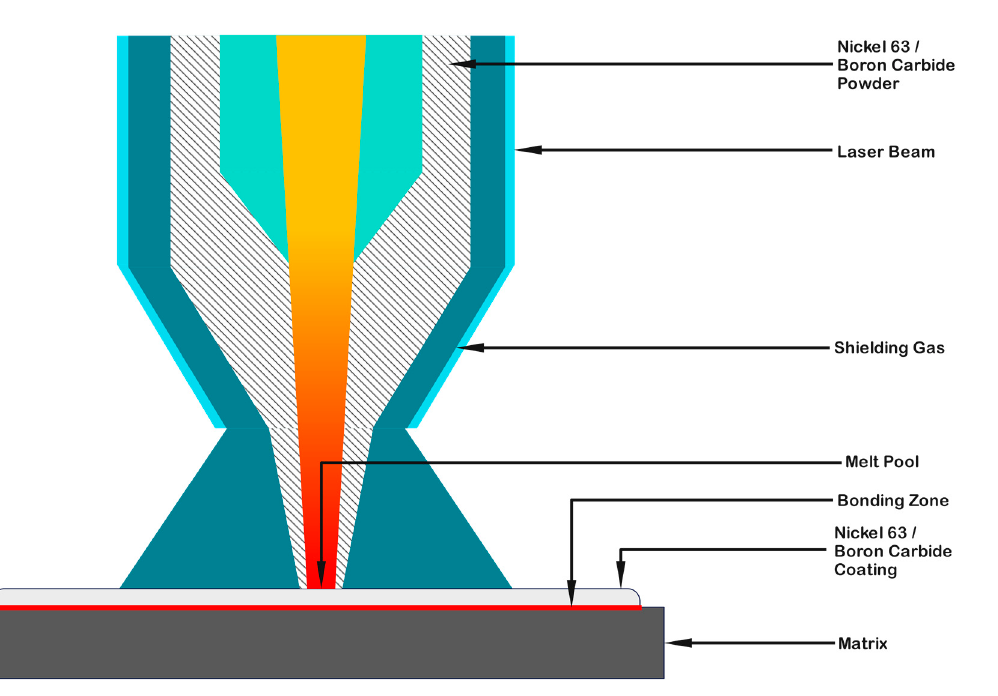
Figure 1. Schematic view of Laser Cladding.